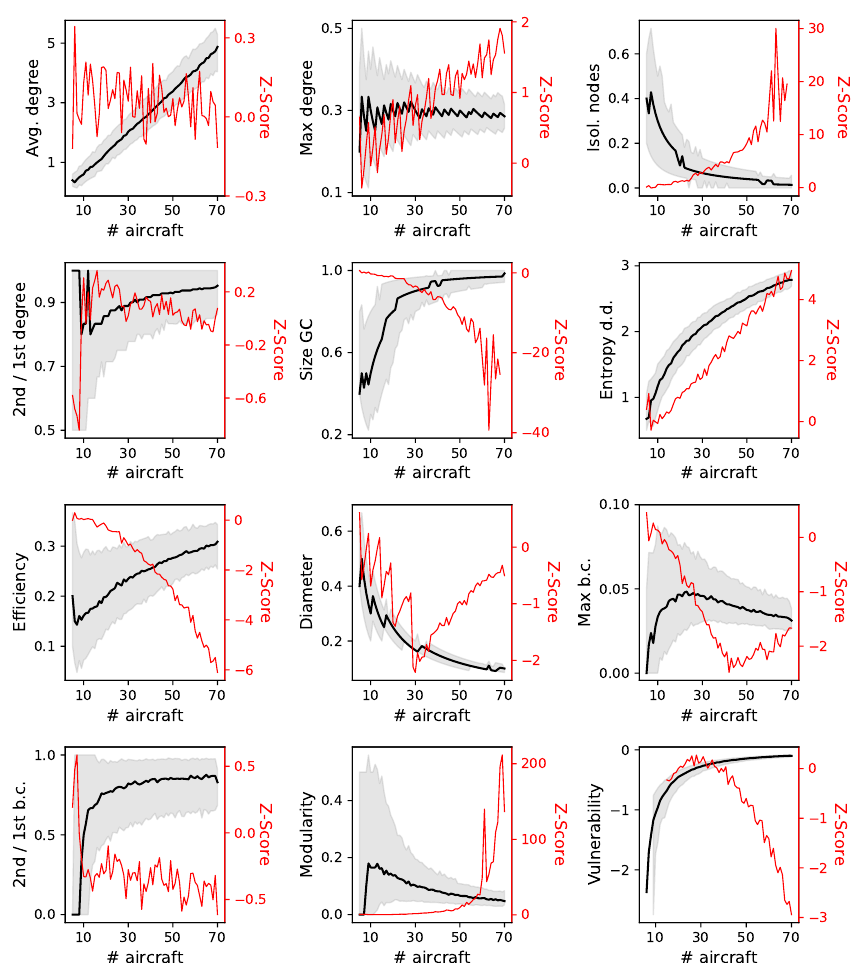
Figure A3. Evolution of the topological metrics yielded by the synthetic model, in the free routing condition, as a function of the number of aircraft. Black (left Y axes) and red lines (right Y axes), respectively, correspond to the raw values of the metrics and their Z-Scores. Grey bands correspond to the 10–90